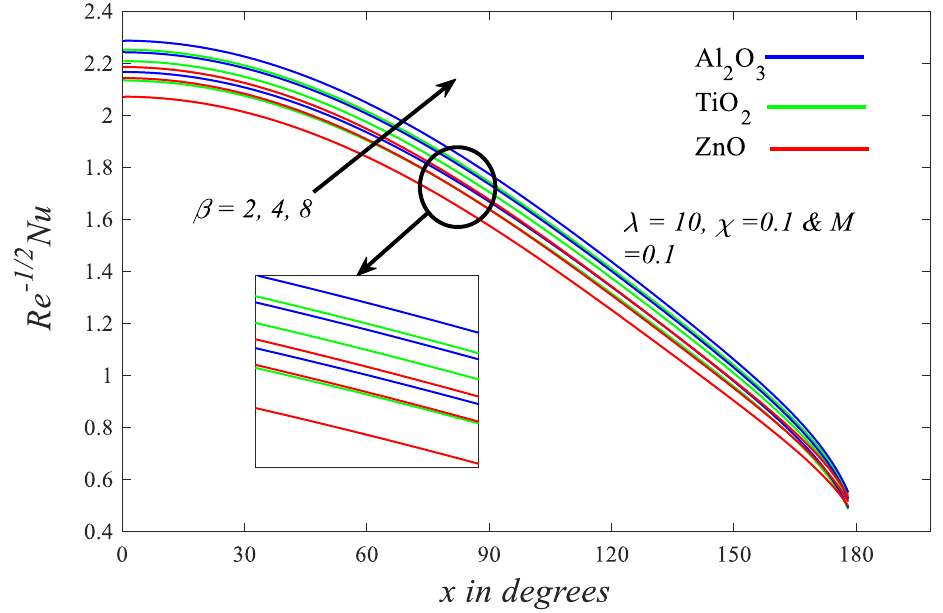
Figure 6. Impression of β on Re − 1/2 Nu . The inset is a partial enlargement of the curves.